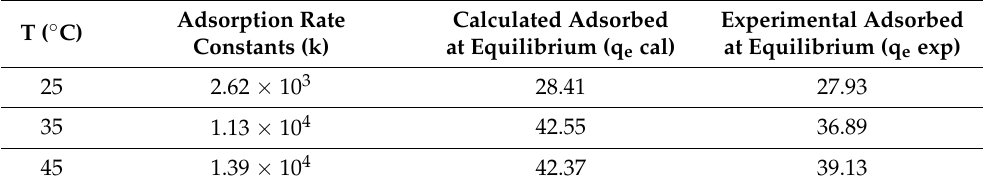
Table 1. The pseudo-second-order reaction kinetics for the uptake of Cd(II) ions by polyester at 25 ◦ C, 35 ◦ C, and 45 ◦